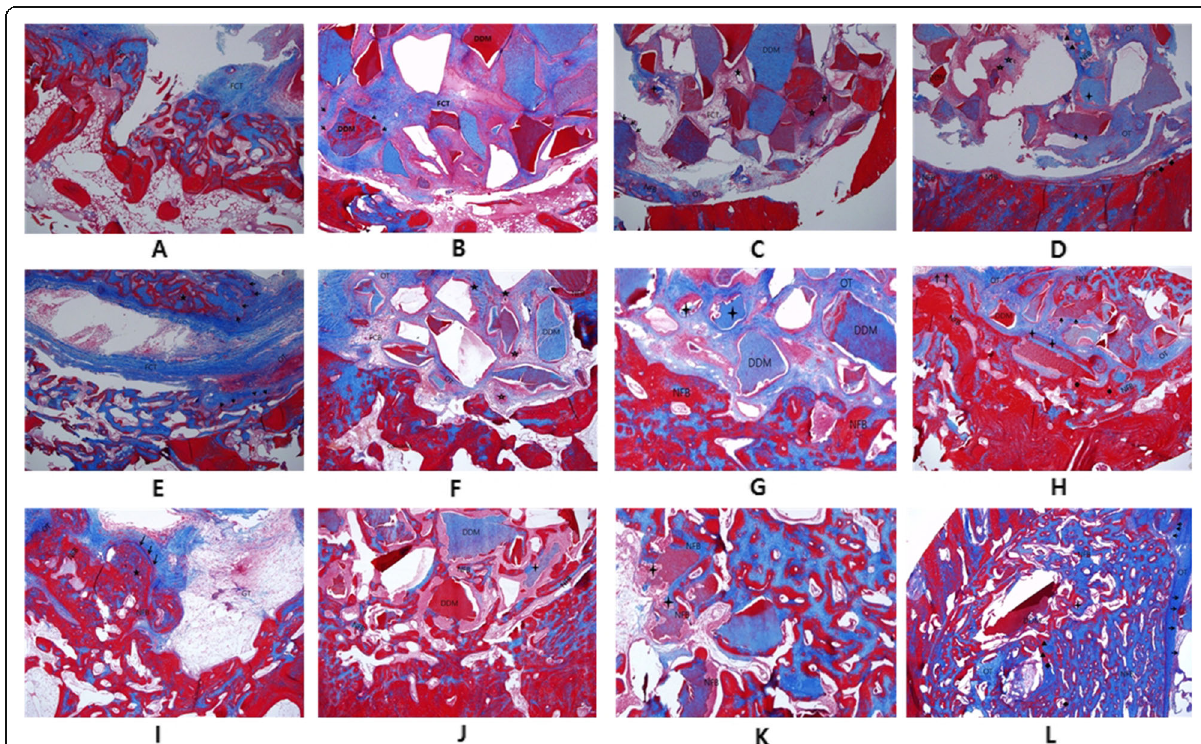
Fig. 3 MT stain (original magnification ×40). A Histologic finding of the control group after 2 weeks (FCT fibrous connective tissue). B Histologic finding of the DDM group after 2 weeks ( → osteoblast, FCT fibrous connective tissue). C Histologic finding of the PRF/DDM group after 2 weeks ( → osteoblast, OT osteoid tissue, ★ blood vessel, : resorbed DDM, FCT fibrous connective tissue, NFB newly formed bone). D Histologic finding of the rhBMP2/DDM group after 2 weeks ( → osteoblast, OT osteoid tissue, ☆ cluster of fibroblast, ◆ osteocyte, : resorbed DDM, ▲ osteoclast, NFB newly formed bone). E Histologic finding of the control group after 4 weeks ( → osteoblast, ★ osteocyte, OT osteoid tissue, FCT fibrous connective tissue). F Histologic finding of the DDM group after 4 weeks ( → osteoblast, OT osteoid tissue, ★ blood vessel, ☆ cluster of fibroblast, FCT fibrous connective tissue, NFB newly formed bone). G Histologic finding of the PRF/DDM group after 4 weeks (: resorbed DDM, OT osteoid tissue, NFB newly formed bone). H Histologic finding of the rhBMP2/DDM group after 4 weeks ( → osteoblast, OT osteoid tissue, ◆ osteocyte, : resorbed DDM, NFB newly formed bone). I Histologic finding of the control group after 8 weeks ( → osteoblast, ★ osteocyte, GT granulation tissue, NFB newly formed bone). J Histologic finding of the DDM group after 8 weeks (: resorbed DDM, NFB newly formed bone). K Histologic finding of the PRF/DDM group after 8 weeks (: resorbed DDM, NFB newly formed bone). L Histologic finding of the rhBMP2/DDM group after 8 weeks ( → osteoblast, OT osteoid tissue, ◆ osteocyte, : resorbed DDM, ▲ osteoclast, NFB newly formed